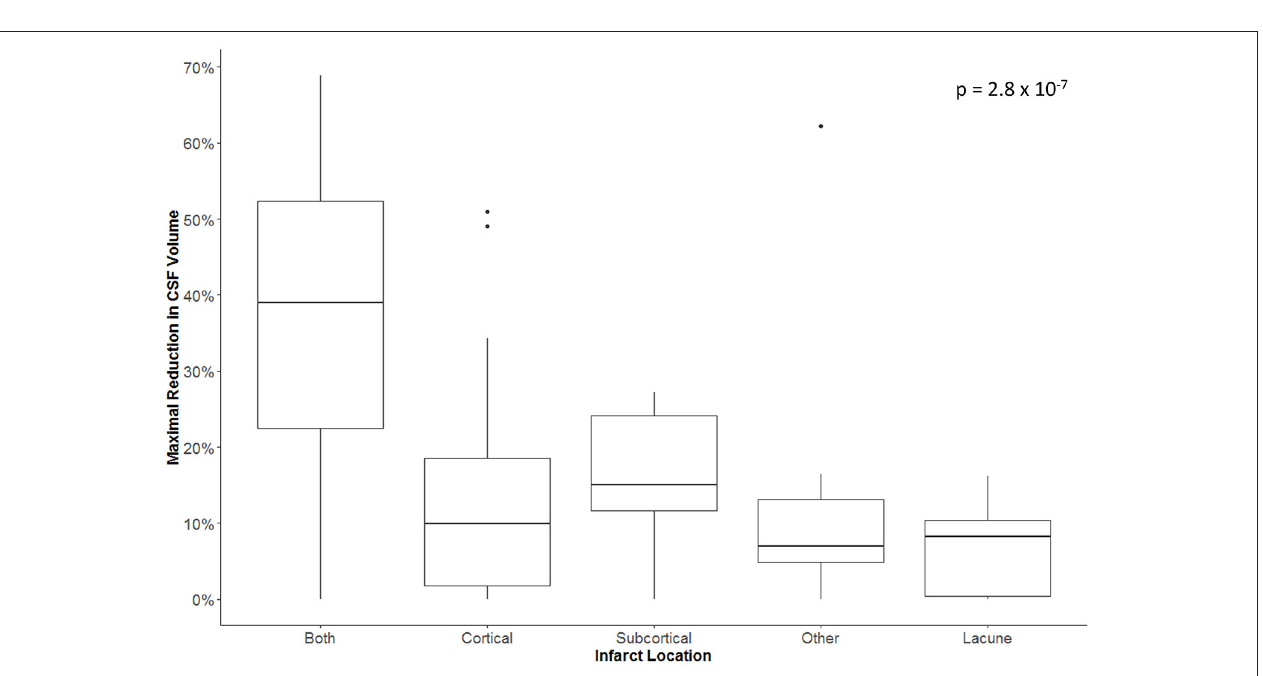
FIGURE 7 | Maximal reduction in CSF volume (as percentage of baseline) in relation to infarct